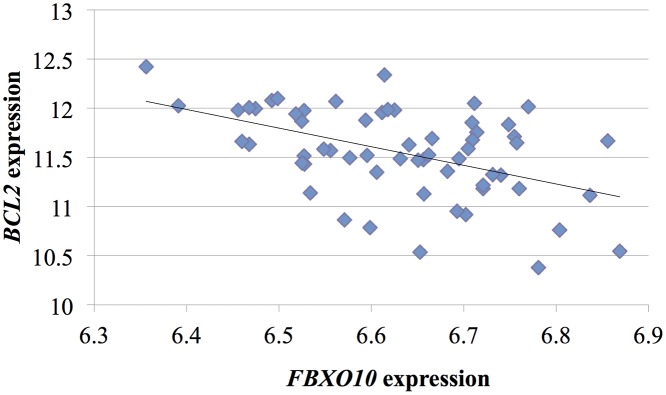
Correlation between FBXO10 and BCL2 gene expression.Individual data points for 60 HapMap CEU samples are presented as blue dots, and the linear trend line is shown in black. Microarray data generated and made publically available by Montgomery et al. [34].